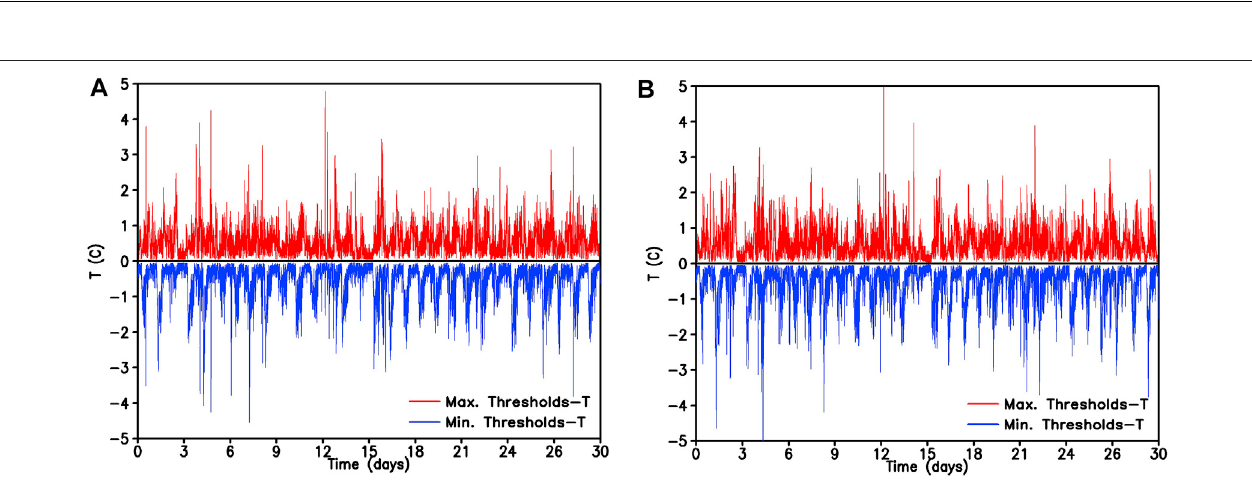
FIGURE 4 | Same as in Figure 2 , but for scheme 7 at TA (A) ; and TB (B) stations from 30 April to 29 May 2016.